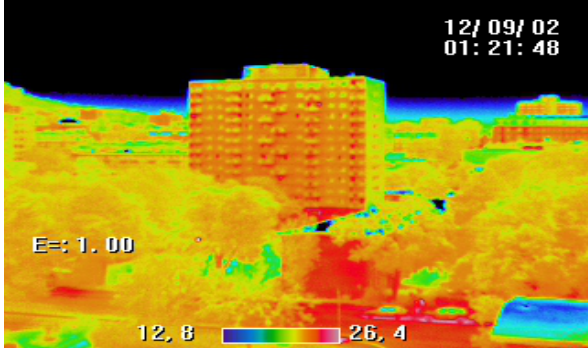
Figure 11. Thermal measurements of buildings facades with an infrared camera (Inf-Rec R300-Z) can be carried out at certain sites for validation